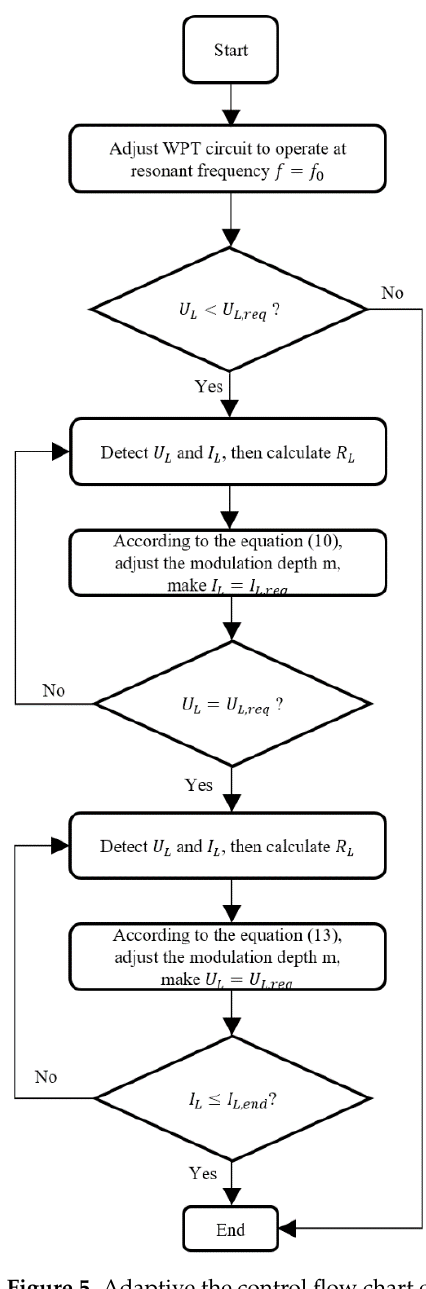
Figure 5. Adaptive the control flow chart of the CC-CV output of the WPT system.